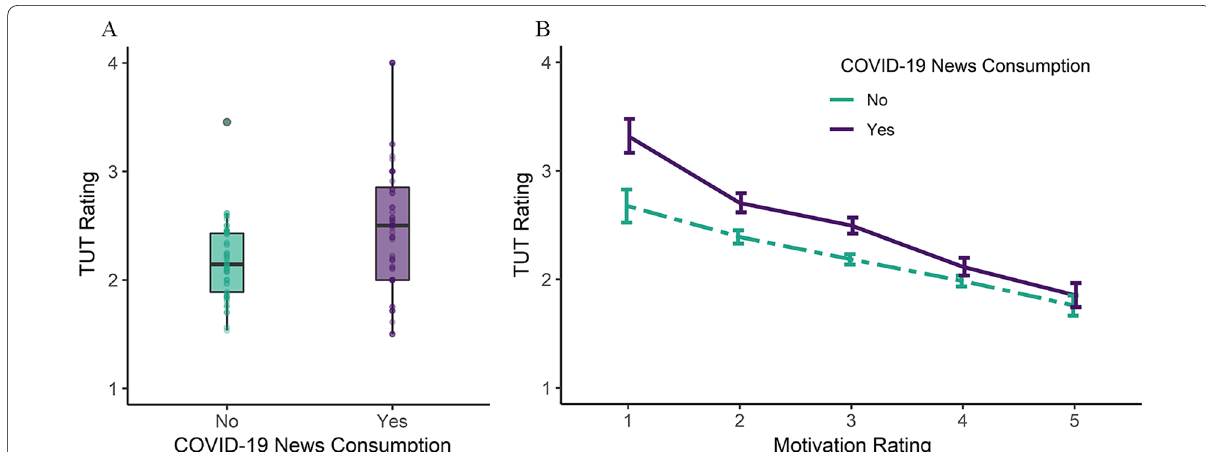
Fig. 1 Relationship Between Task‑Unrelated Thought Ratings and COVID‑19 News Consumption (Study 1). Note Task‑unrelated thought (TUT) ratings (1 completely on‑task to 4 completely off‑task) are shown as a function of COVID‑19 news consumption (panel A ) and an interaction of = = motivation ratings and COVID‑19 news consumption (panel B ), from Study 1. Panel A: boxplots of average TUT ratings when participants did and did not consume COVID‑19 news; individual averages shown as dots. COVID‑19‑related news consumption (“Yes”; shown in purple/darker color) was associated with higher ratings of TUT (1 completely on‑task to 4 completely off‑task) compared to the absence of COVID‑19‑related news = = consumption (“No”; shown in green/lighter color). Panel B : Line graph of average TUT ratings when participants did and did not consume COVID‑19 news at different levels of task motivation (1 not motivated at all to 5 extremely motivated). Error bars represent the standard error of the mean. = = The association between TUT and COVID‑19 news consumption varied as a function of task motivation